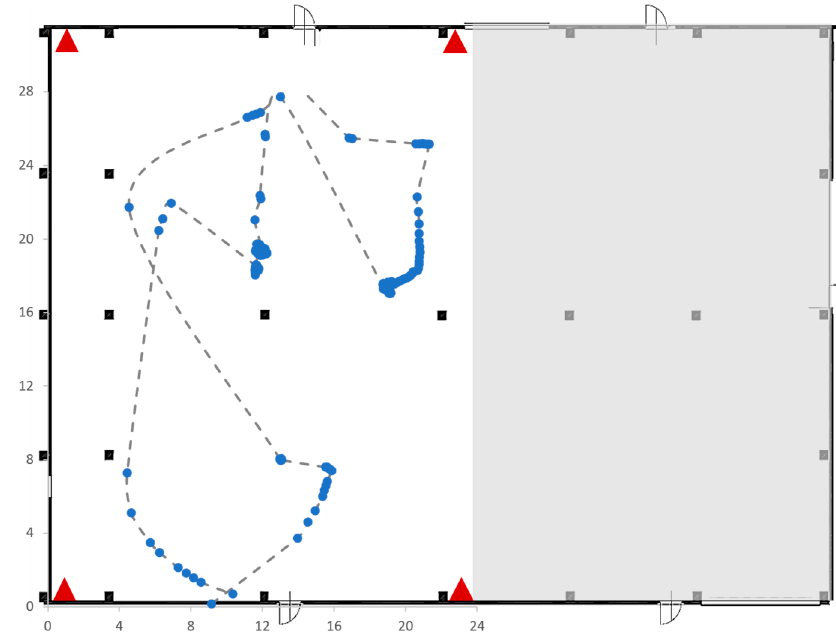
Figure 18. Trajectory followed by the tag in Test 1.